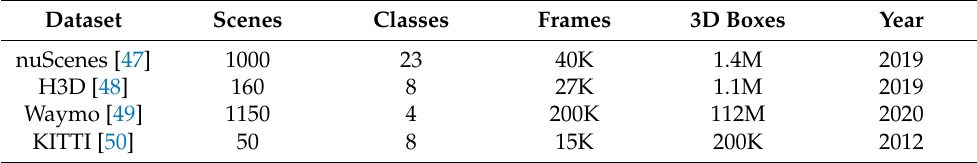
Table 1. A summary of public datasets on 3D object detection in autonomous